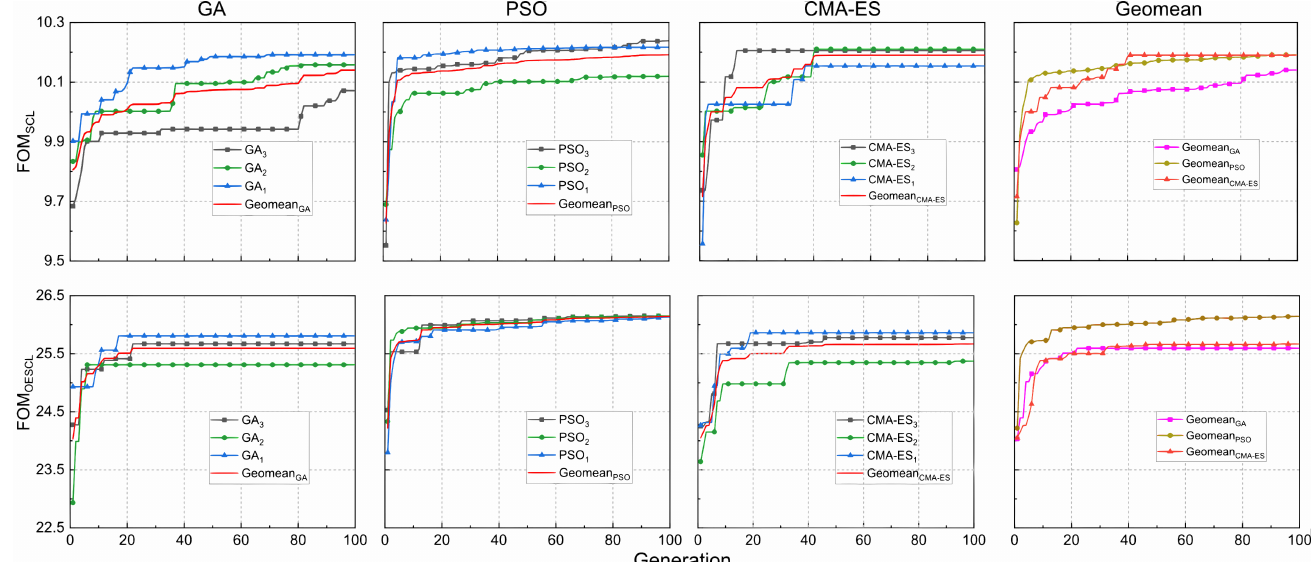
Figure 3. History of the FOM for each algorithm (GA, PSO and CMA-ES) in every optimization process. ( Top ) SCL band. ( Bottom ) OESCL